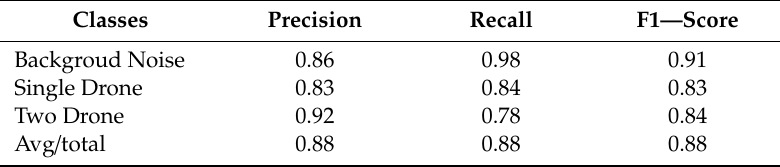
Table 8. Classification Report for CoNN with Mean Instantaneous